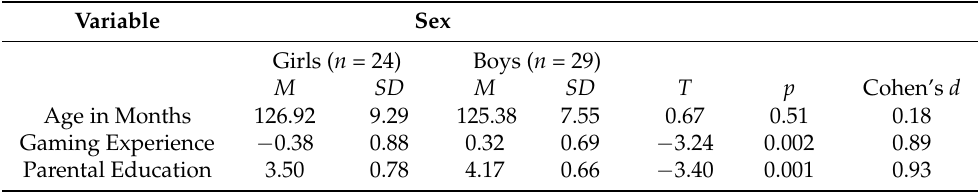
Table 1. Demographic statistics, separated by